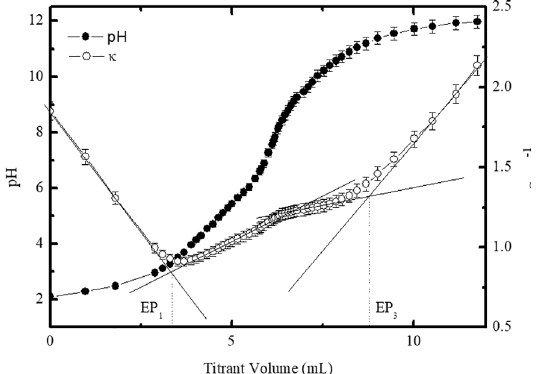
Figure 3. Typical curves of simultaneous potentiometric-conductometric titrations (sample A). The equivalence points are determined by using the graphical